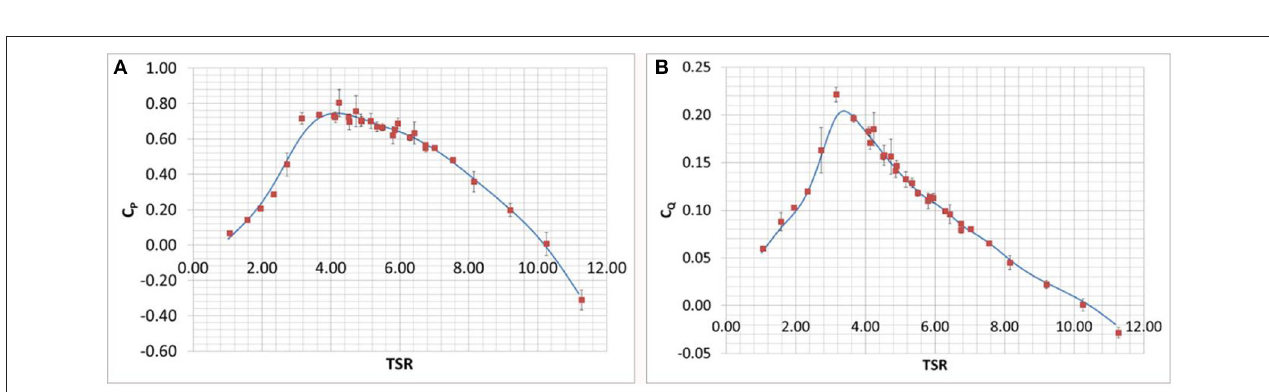
FIGURE 5 | The GEM reduced-scale model tested in the towing-tank. Scale 1:8 (A) . Schematic of the GEM system in a steady-state condition, immersed in a current V (due to the advancing carriage speed V); the equilibrium involves the cable tension force TC, the buoyancy B, and the total horizontal force FH (B) .